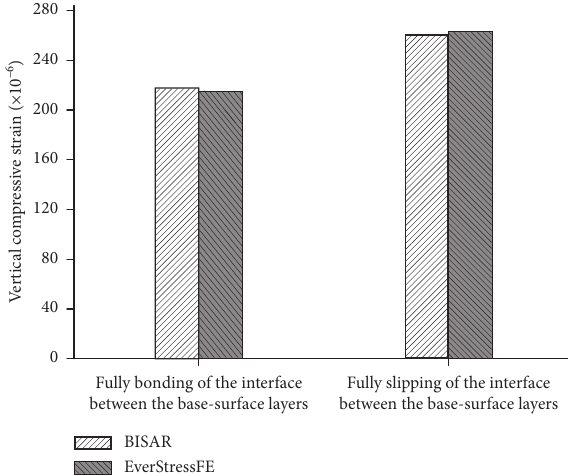
Figure 9: Maximum vertical compressive strain at the top of the subgrade (unit: 10 − 6